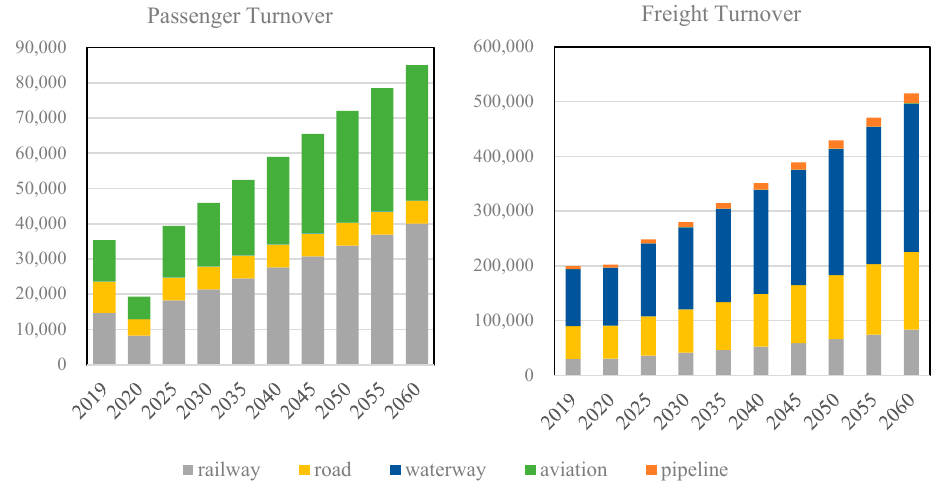
Figure 8. Forecast of passenger and freight turnover.